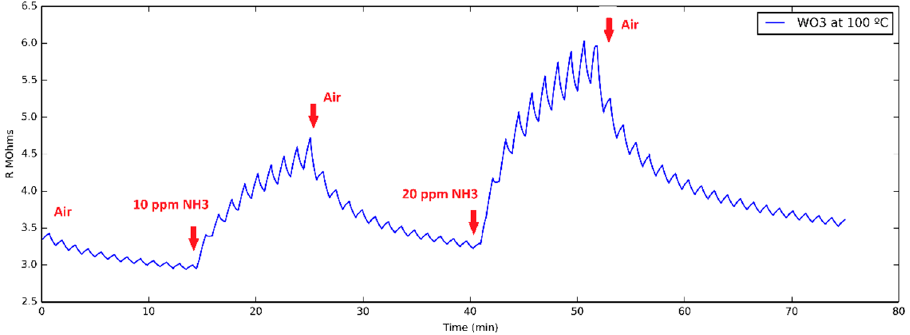
Figure 1. Typical evolution of the resistance of a WO 3 nanoneedle sensor operated at 100 °C to two successive 10 and 20 ppm pulses of ammonia. The ripple in the resistance value is generated by a pulsed UV light (30 s ON and 30 s OFF) applied during the whole measurement process.